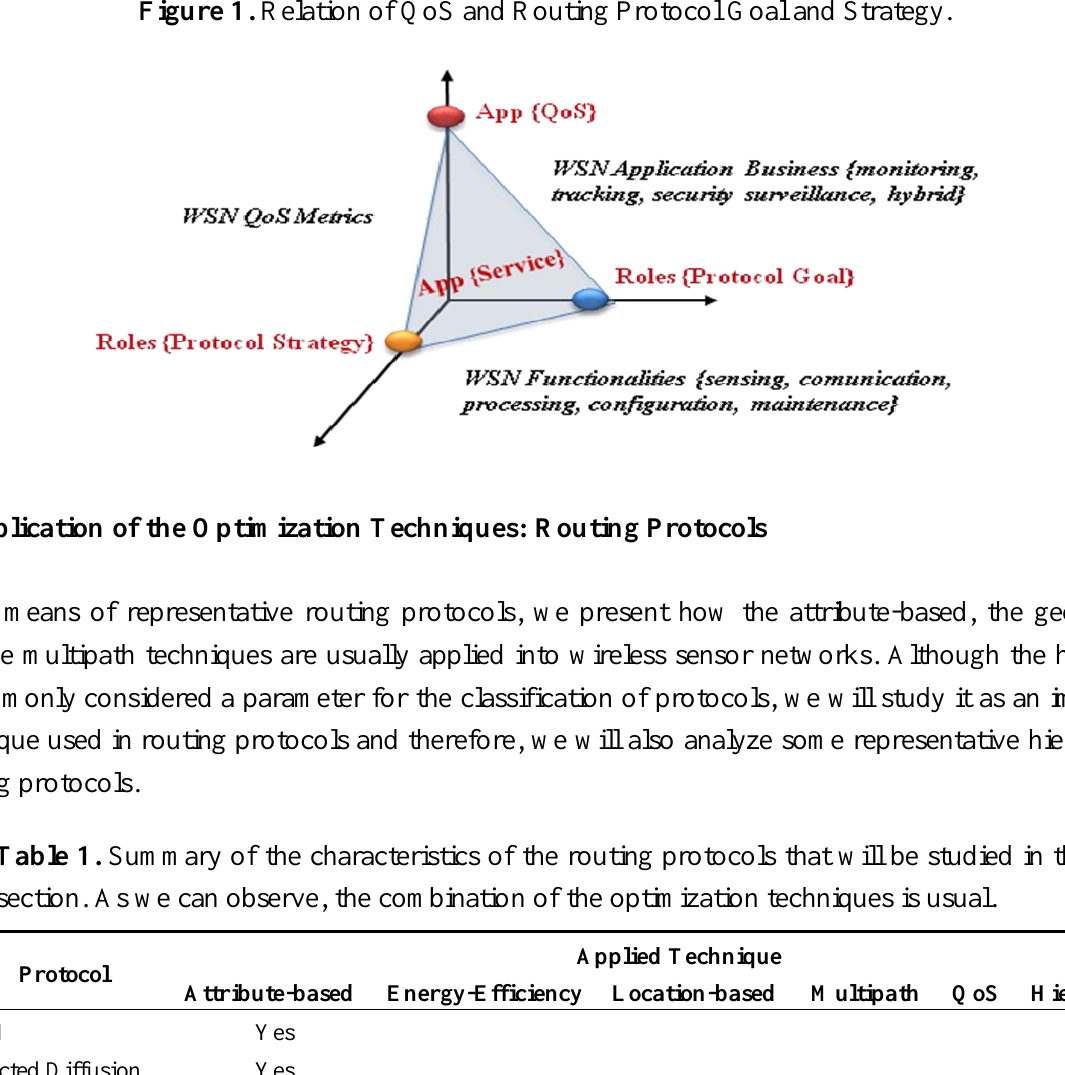
Figure 1. Relation of QoS and Routing Protocol Goal and